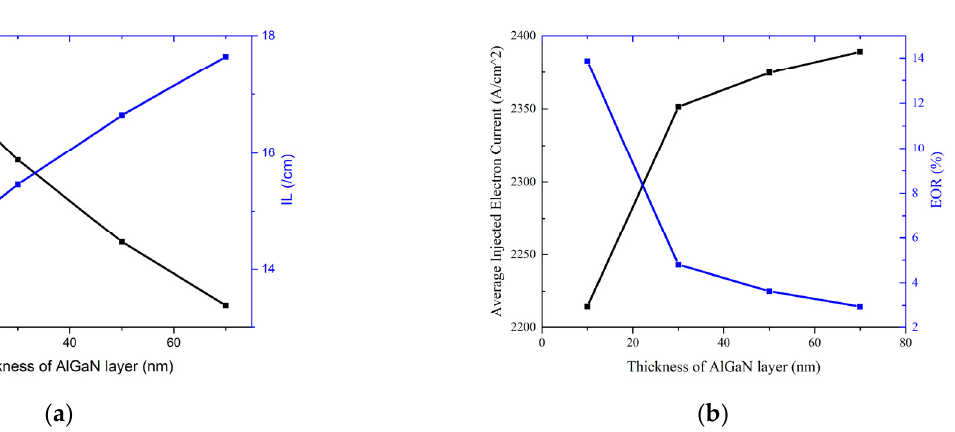
Figure 5. Variations of simulated OCF, IL, average injected electron current and EOR vs. thickness of AlGaN layer in CLQB. ( a ) OCF (black) and IL (blue) vs. thickness of AlGaN layer; ( b ) Average injected electron current (black) and EOR (blue) vs. thickness of AlGaN layer.